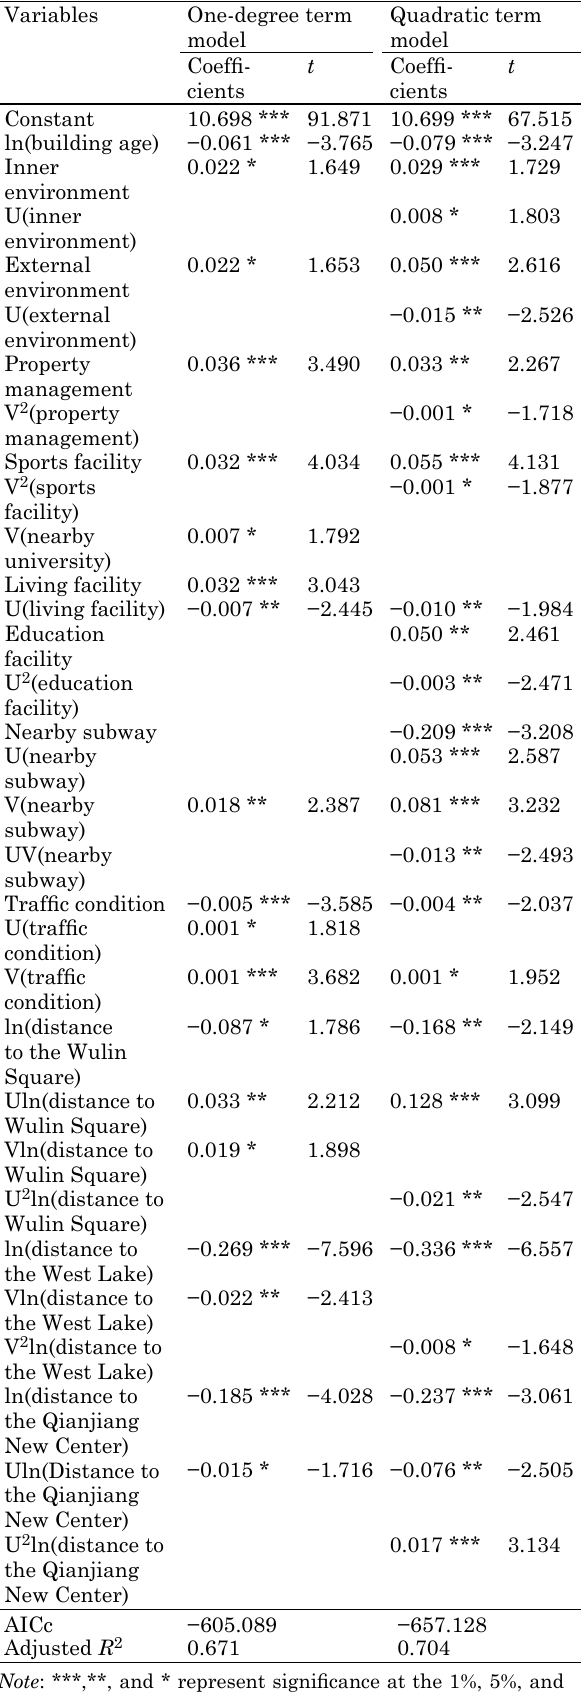
Table 3. Regression results of spatial expansion